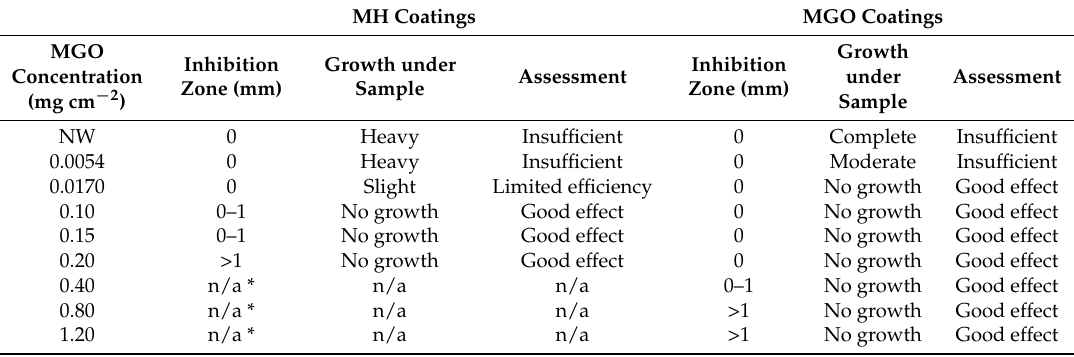
Table 4. Effect of MGO concentration on the growth of E. coli when applied as a physical coating onto nonwoven samples.